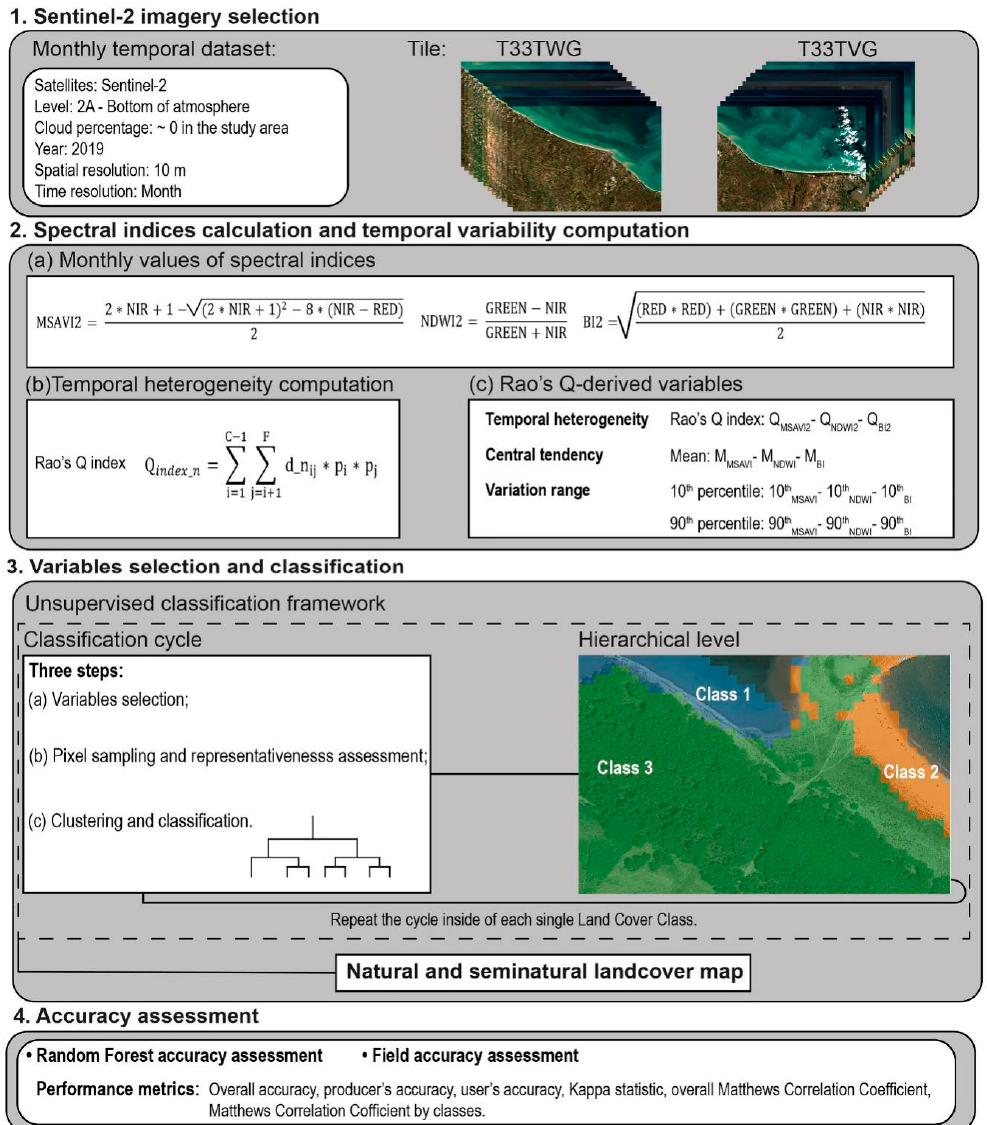
Figure 2. Workflow synthesizing the full mapping procedure of coastal dune Semi-natural and natural cover types with temporal MSAVI2, NDWI2, BI2 series and Random Forest classification approach.